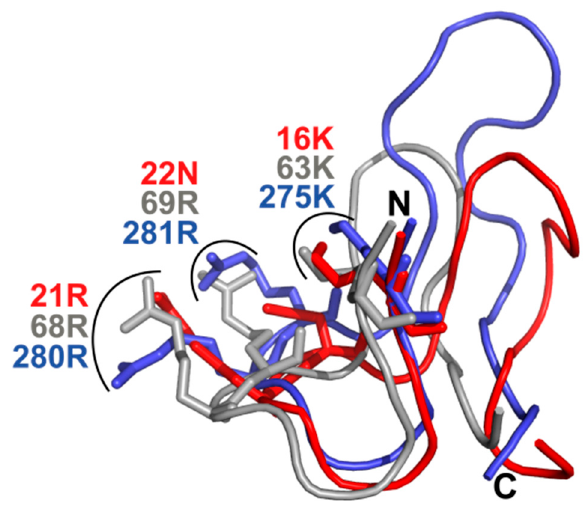
Figure 6. Spatial orientation of the β 1- α 1 loop regions when superimposing the catalytic core residues of Tb Par42 (H271, C333, L374, H377), Tb Pin1 (H11, C68, S109, H112) and h Pin1 (H59, C113, S154, H157); Tb Par42 (PDB:6GMP) (blue), h Pin1 (PDB:1NMW) (gray), and Tb Pin1 (PDB:2LJ4) (red).